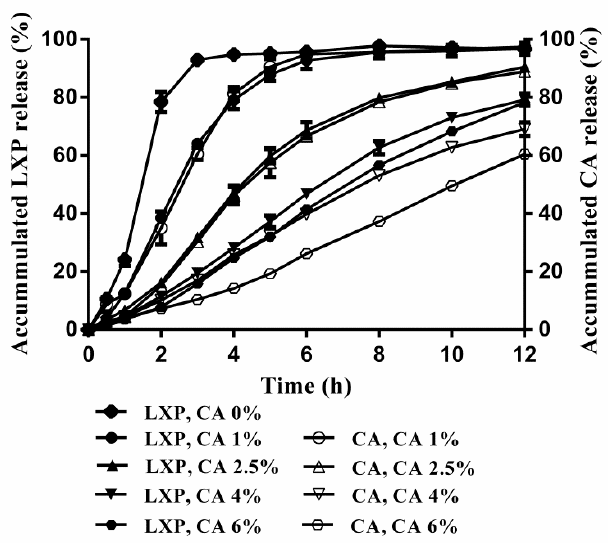
Figure 3. The simultaneous release profiles of citric acid and loxoprofen from sustained release pellets at different concentrations of citric acid ( n = 3).